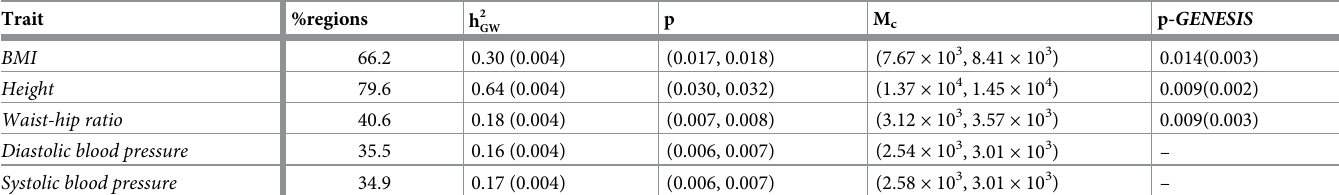
Table 1. Genome-wide estimates of polygenicity and total SNP heritability.